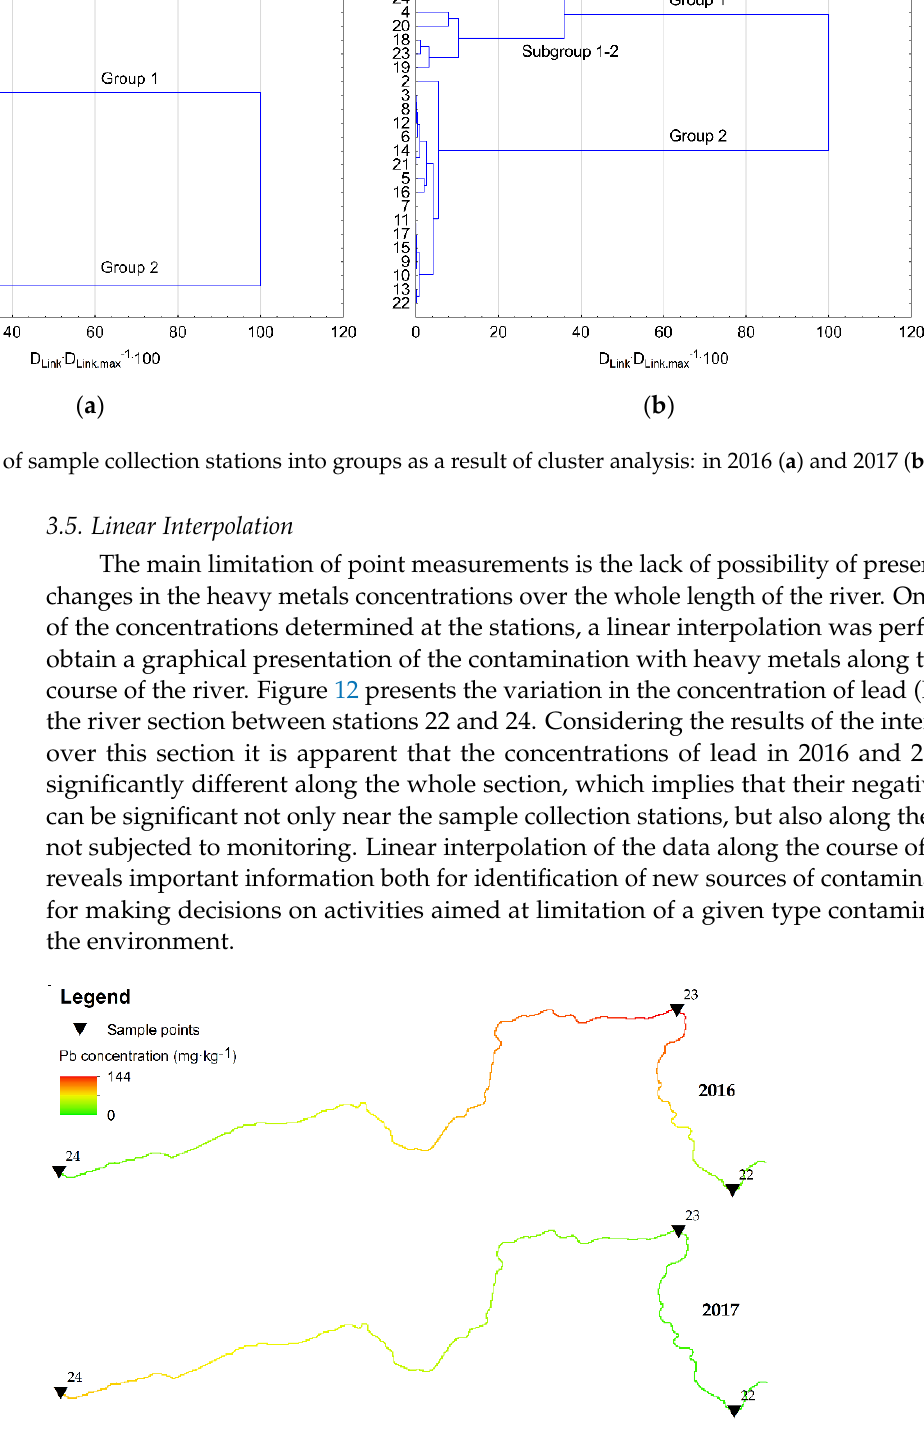
Figure 12. Linear interpolation of Pb concentration between sample collection stations 22–24.